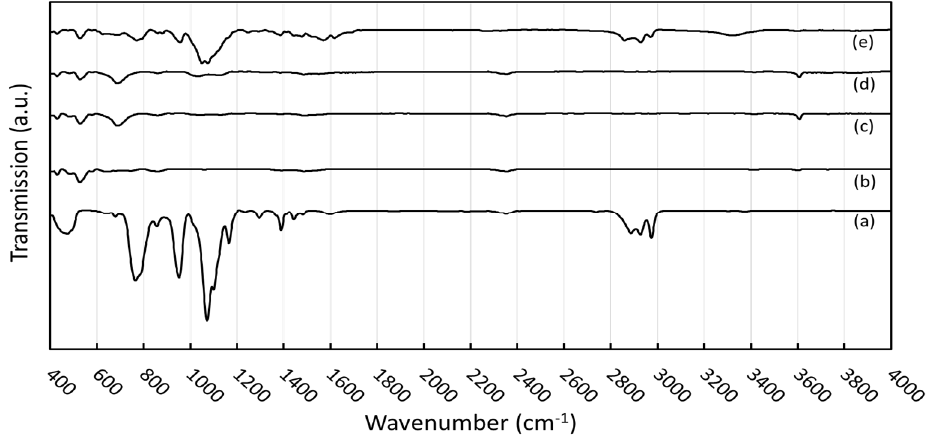
Figure 2. FTIR spectra of ( a ) silane coupling agent (KBE903), ( b ) non-treated Sm 2 O 3 , ( c ) treated Sm 2 O 3 with 5 pph KBE903, ( d ) treated Sm 2 O 3 with 10 pph KBE903, and ( e ) treated Sm 2 O 3 with 20 pph KBE903.